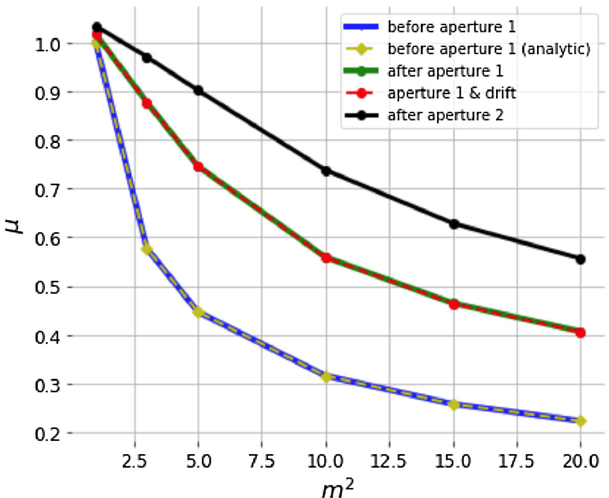
FIG. 7. Degree of coherence with varying m values before and after the